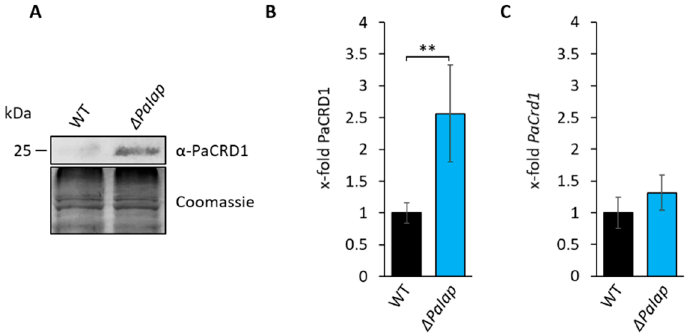
Figure 5. Deletion of PaIap prevents proteolytic turnover of PaCRD1. ( A ): Western blot analysis of isolated mitochondria of 7-day-old wild type (WT) and Δ PaIap . Coomassie staining was used as loading control. ( B ): Quantification of PaCRD1 in ( A ). PaCRD1 levels were determined and related to wild type (set to 1). Data represent mean ± SD (n = 5). ** p < 0.01. ( C ): Transcript analysis of 5-day- old wild type and Δ PaIap grown on M2. PaCrd1 transcript level was analyzed by qPCR and normal- ized to PaPorin expression level. Data represent mean ± SD (wild type: n = 6, Δ PaIap : n = 3).